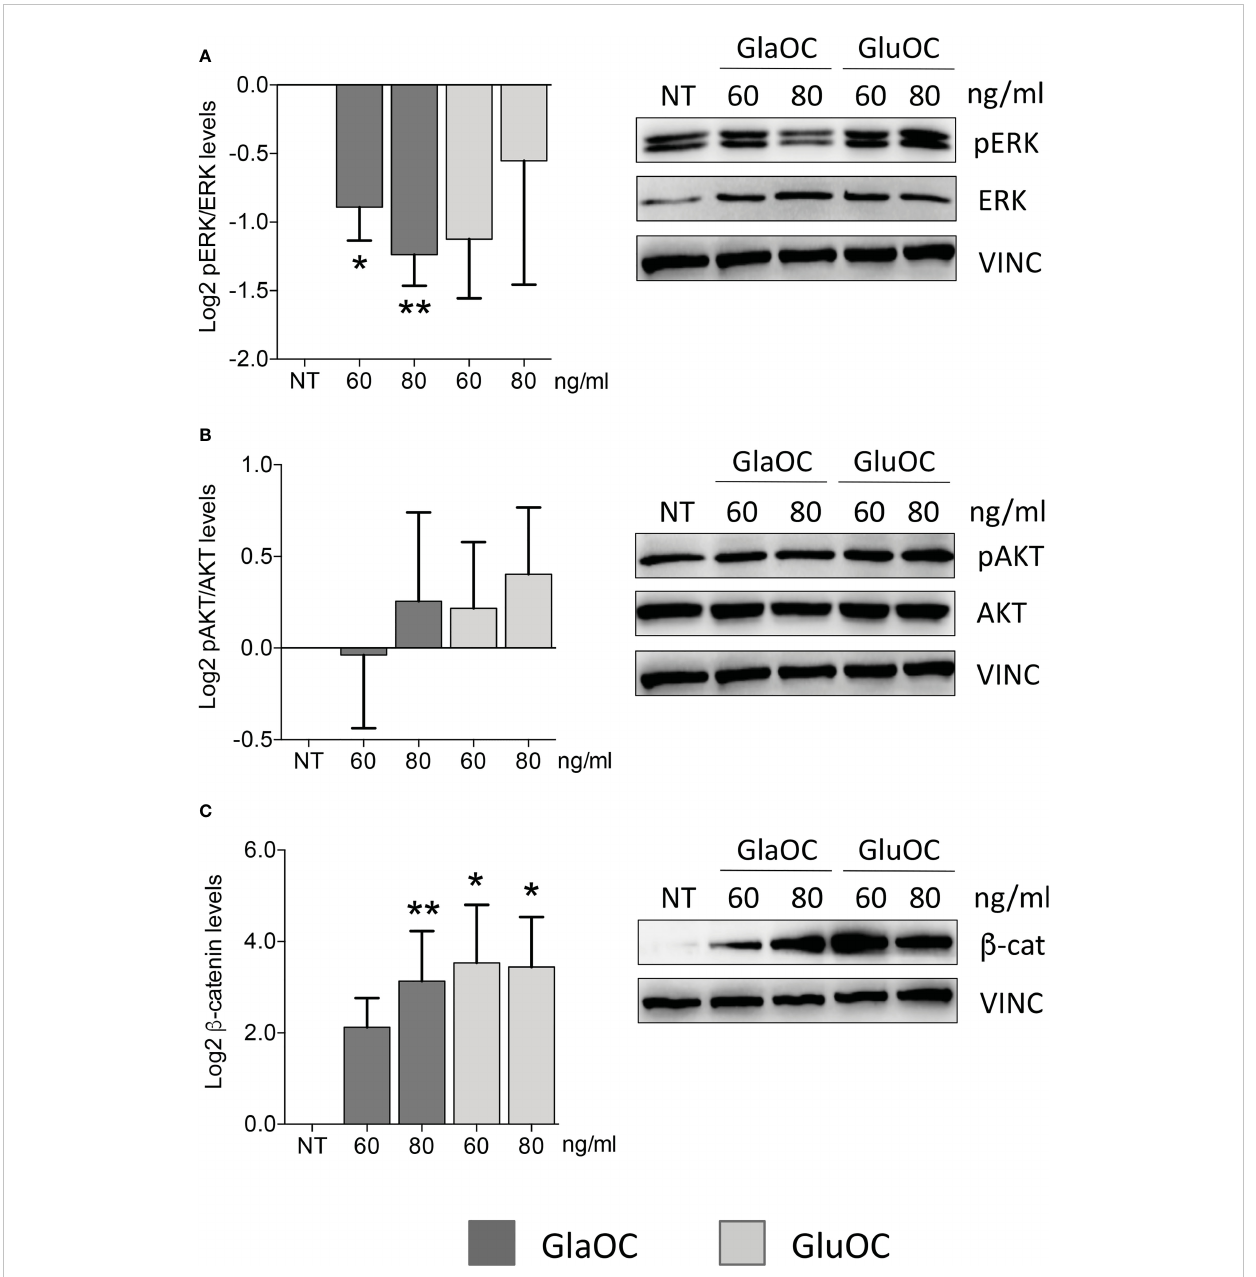
FIGURE 1 Effects of the GlaOC and GluOC stimulation on intracellular signaling pathways in human parathyroid cells. PAds-derived cells were incubated for 10 minutes with increasing concentrations of GlaOC (dark grey columns; 60-80 ng/mL) and GluOC (light grey columns; 60-80 ng/mL) (n=4). A representative western blot is shown for each experimental condition and data are expressed as mean ± SEM. (A) GlaOC and GluOC effects on basal pERK/ERK levels (*, P=0.019; **, P=0.004). (B) GlaOC and GluOC effects on basal pAKT/AKT levels. (C) GlaOC and GluOC effects on basal active b - catenin levels (*, P=0.048; **, P=0.042). VINC, vinculin was used as loading